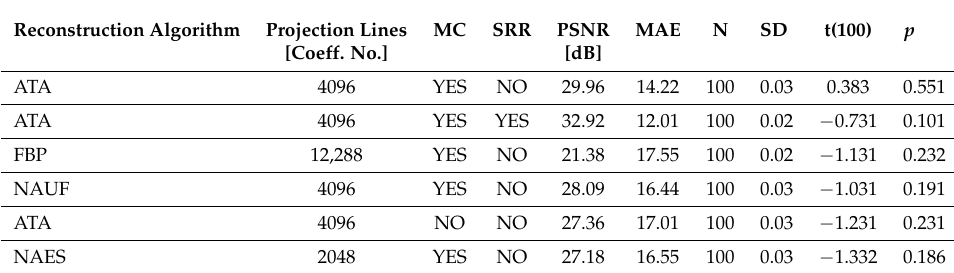
Table 3. The performance of different reconstruction algorithms for XCAT phantom. Reconstruction Algorithm Projection Lines [Coeff. No.]